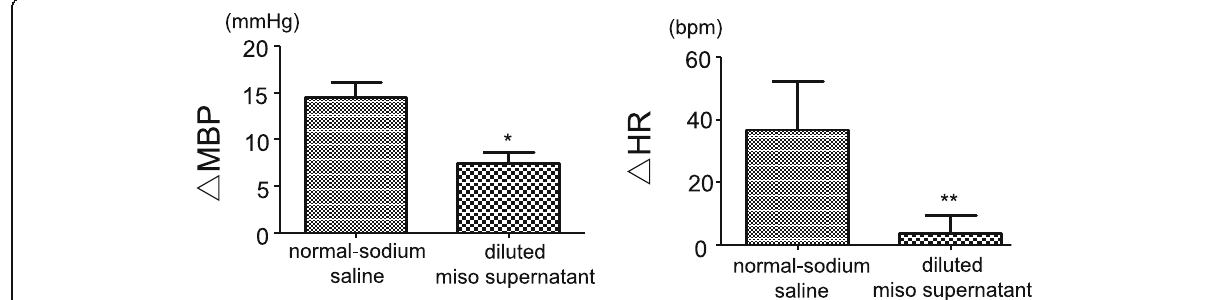
Fig. 6 Changes in mean blood pressure (left) and heart rate (right) after high-sodium saline ICV infusion. n = 5 for each. * p < 0.05, ** p < 0.01 high-sodium saline versus miso supernatant. ICV,